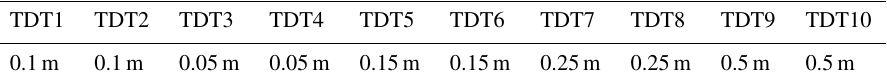
Table 4. Buried depths of the paired TDT point soil sensors. TDT3–10 are only present at sites installed on or after 31 March 2016. At the Heytesbury site TDT9 and TDT10 are buried at 0.05m depth due to the presence of solid chalk. TDT pair 1 and 2 are located 1m apart, whilst the additional TDTs (3–10) are buried with 0.3m space between the paired sensor and 0.15m horizontal distance between pairs. Data for each individual sensor are provided. TDT1 TDT2 TDT3 TDT4 TDT5 TDT6 TDT7 TDT8 TDT9 TDT10 0.1m 0.1m 0.05m 0.05m 0.15m 0.15m 0.25m 0.25m 0.5m